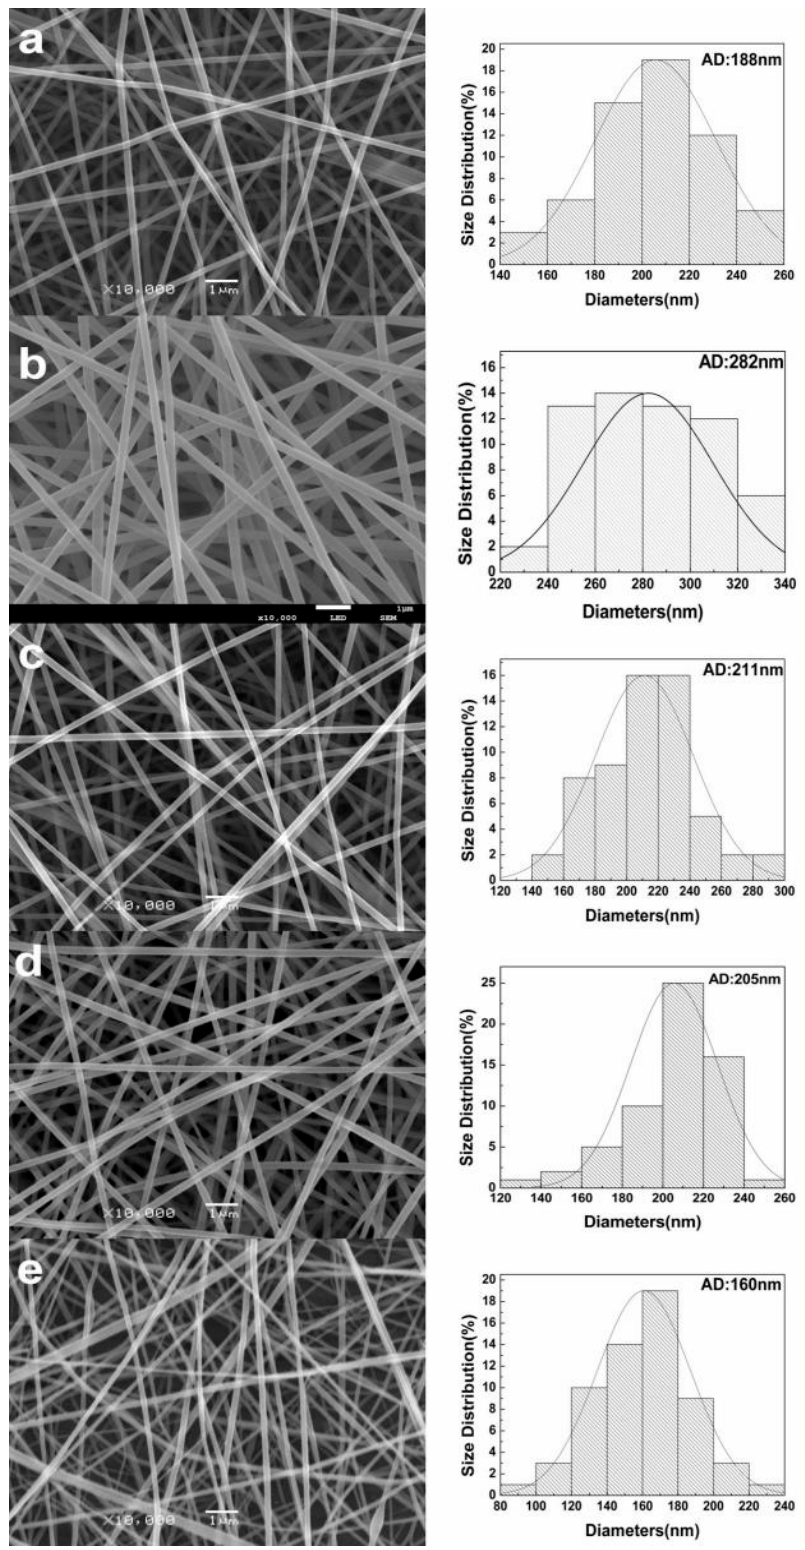
Figure 4. Images and diameter distribution of gelatin / pullulan nanofibers with di ff erent concentrations and mass ratios: ( a ) concentration = 20%; mass ratio = 25 / 75; ( b ) 25%, 25 / 75; ( c ) 25%, 33 / 67; ( d ) 25%, 40 / 60; ( e ) 25%, 50 / 50.